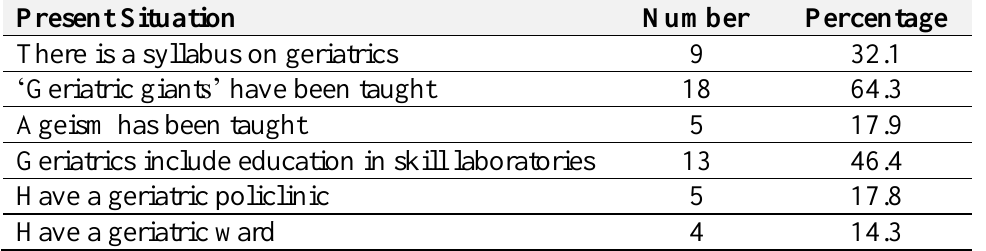
Table 2. Teaching Geriatrics at the undergraduate level of medicine in Indonesia